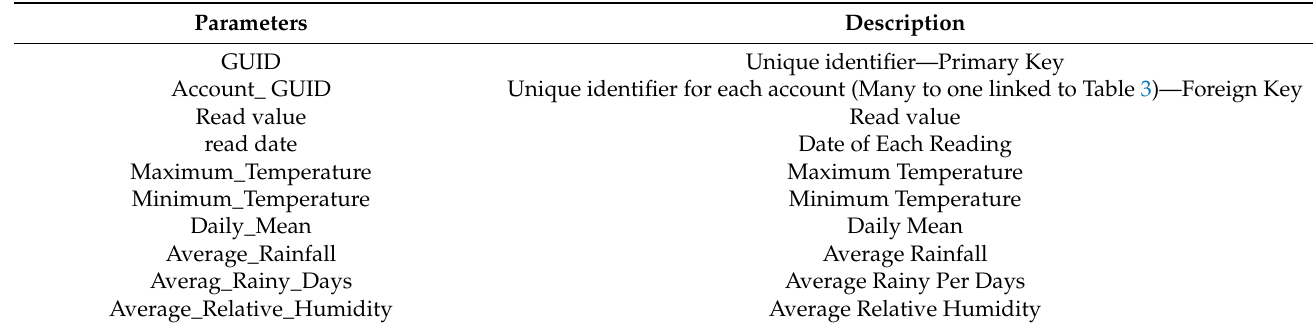
Table 4. Reading Information Parameters (Many to